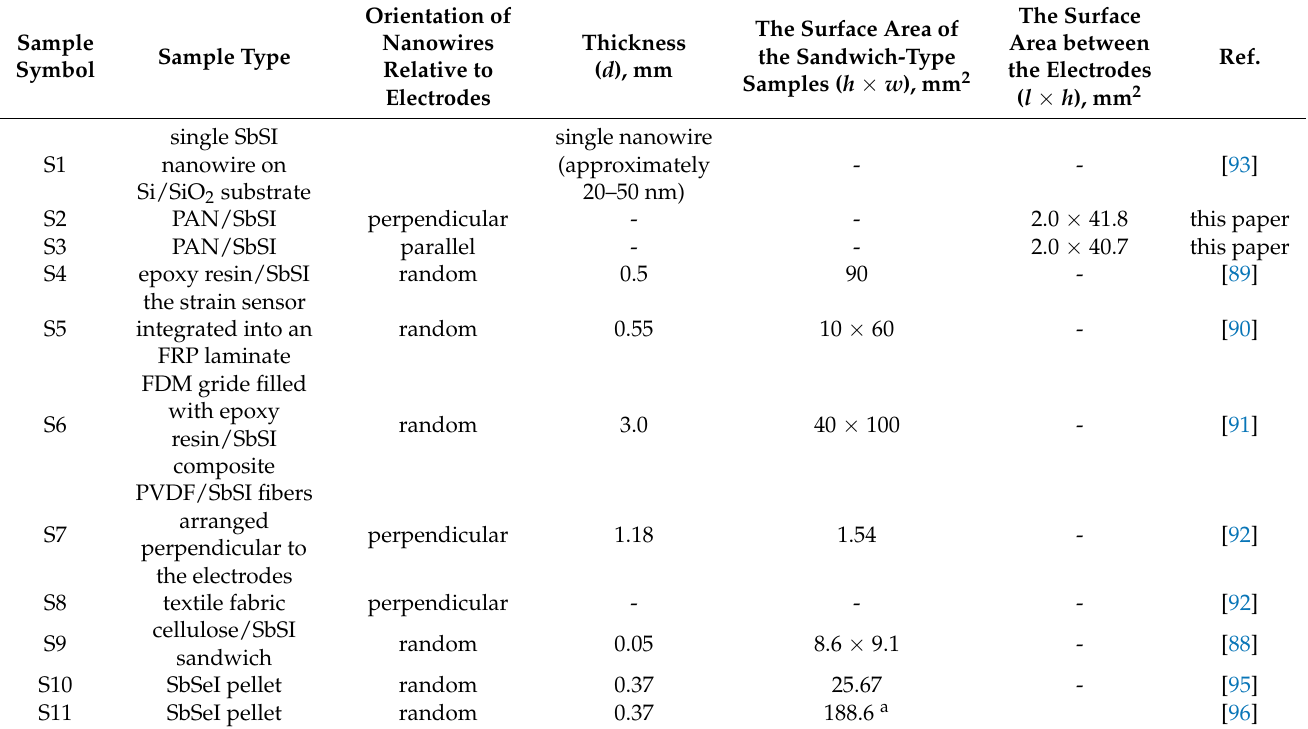
Figure 11. Drawings representing the two configurations of the examined samples: ( a ) sandwich-type and ( b , c ) planar-type. Here, d is the sample thickness, and h , w are the height and width of the sandwich-type samples surface, respectively, while l denotes the distance between the electrodes in the planar-type samples. In the case of the PAN/SbSI nanocomposites, the fibres can be arranged in either ( b ) a perpendicular or ( c ) a parallel direction compared to the electrodes in the planar-type samples. Table 2. Dimensions and the electrical resistivity of the examined samples.